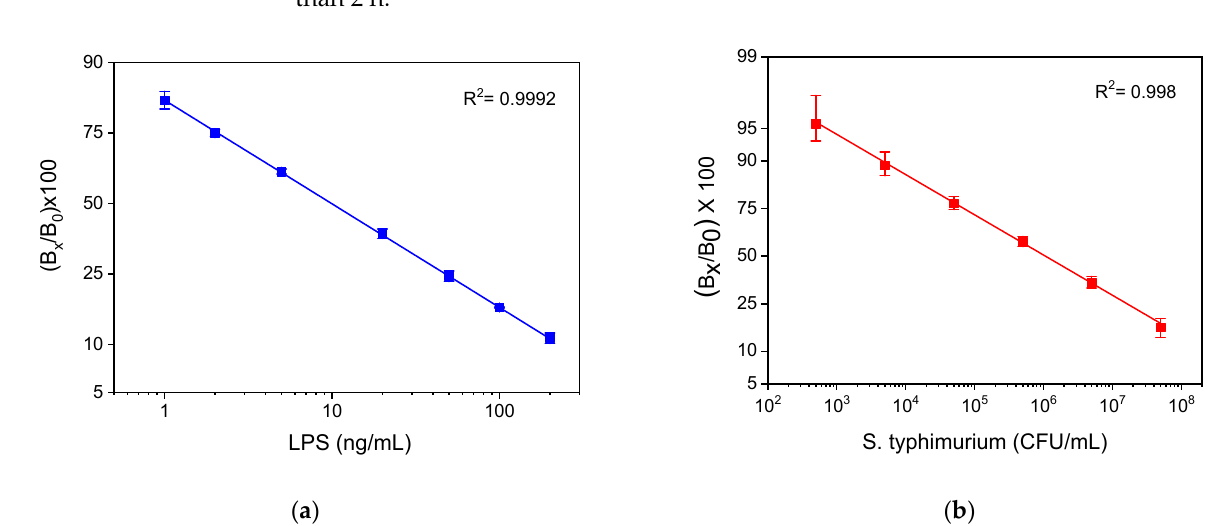
Figure 9. Typical calibration curves obtained for ( a ) LPS and ( b ) bacteria with the in-house developed competitive ELISA. Each point is the mean value of three measurements ± SD.